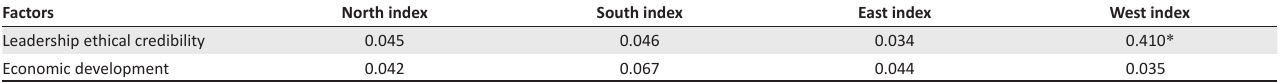
TABLE 3: Correlation matrix for leadership ethical credibility and economic development. Factors